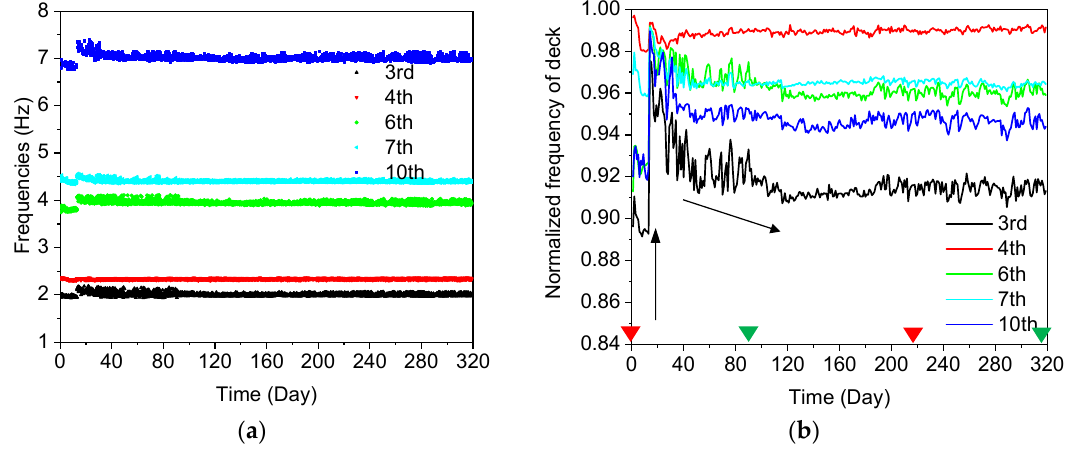
Figure 13. Modal frequencies of the arch lateral and deck vertical vibrations from 1 March 2017 to 31 July 2018: ( a ) the long-term frequencies of the coupled modes; ( b ) the average normalized frequencies of the coupled modes. (The two triangle marks in green: the 90th day (15 August 2017) and the 320th day (31 July 2018); The two triangle marks in red: the 1st day (1 March 2017) and the 220th day (1 March 2018)).